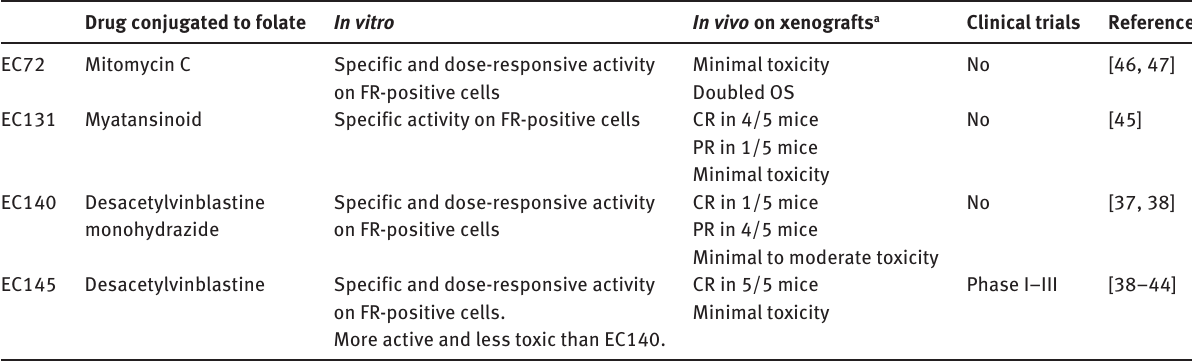
Table 3 FR-targeted delivery drugs in in vivo and in vitro